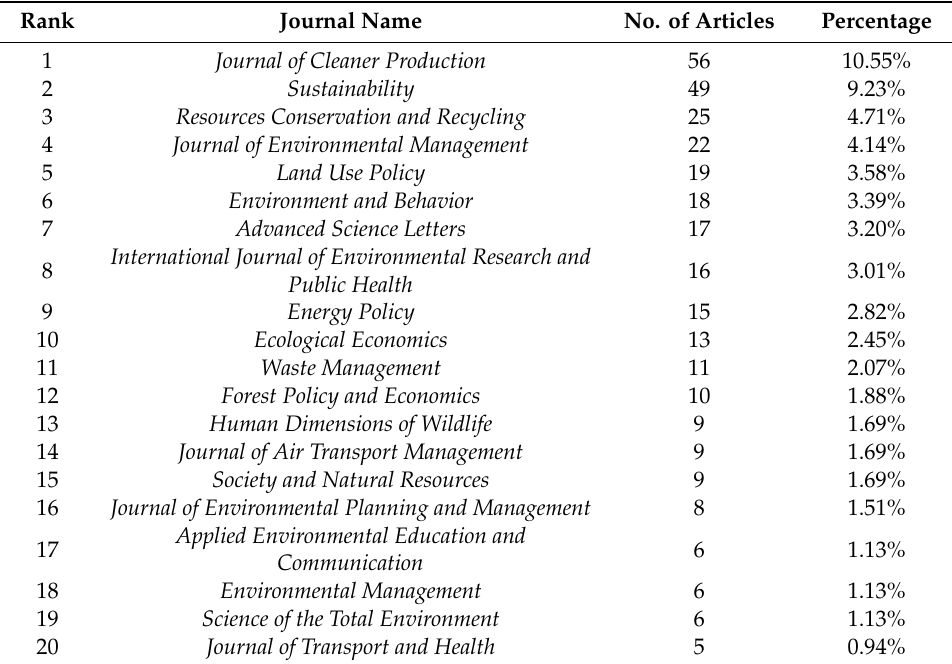
Table 1. Primary source journals and their